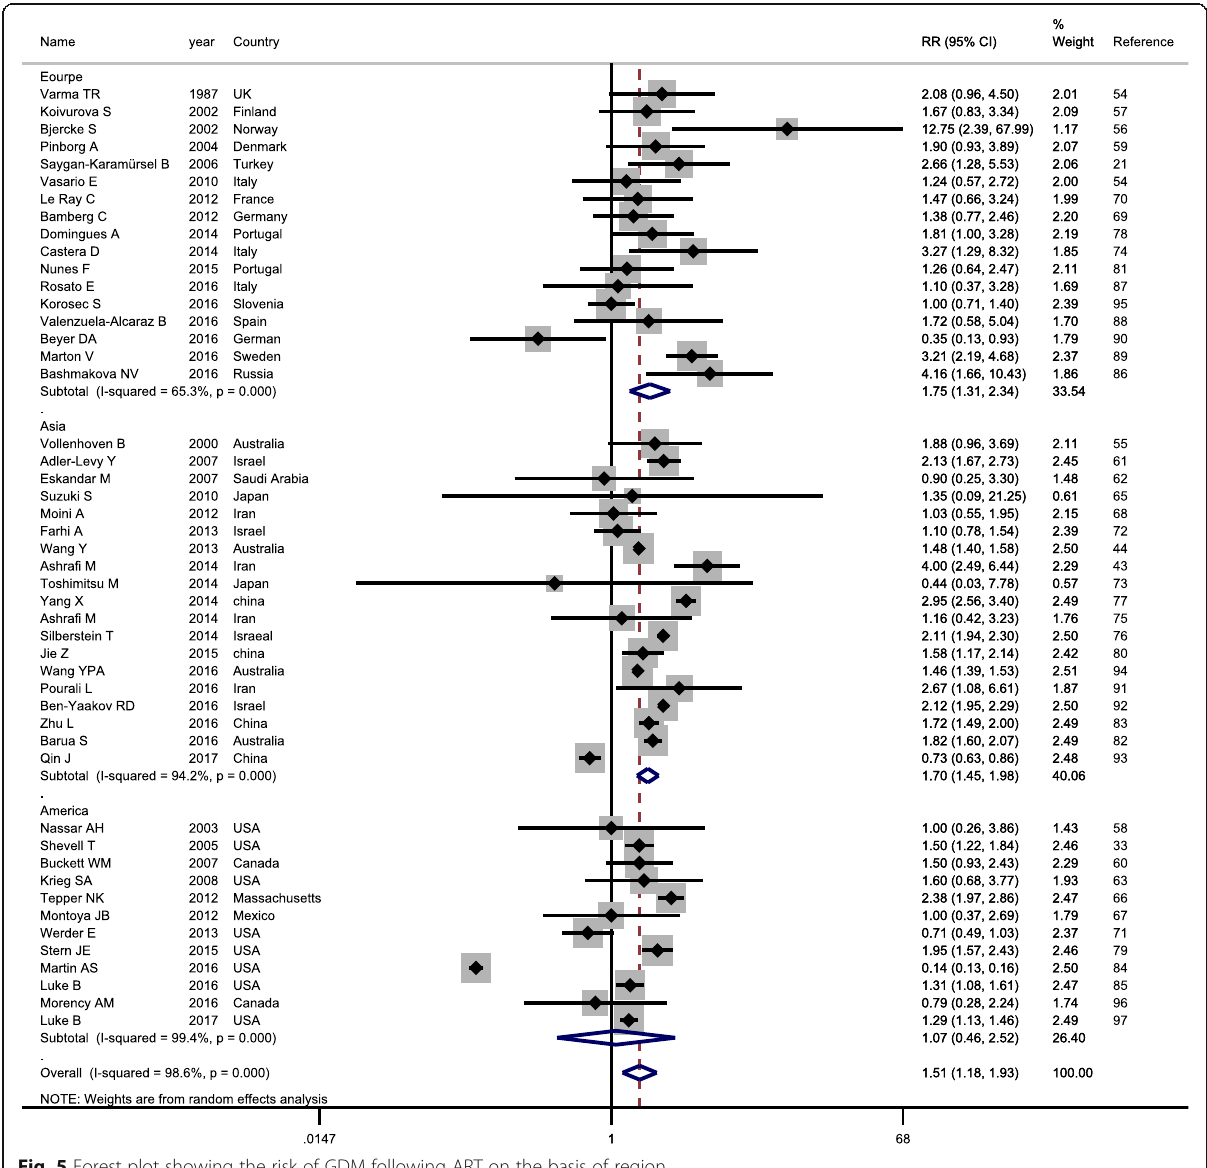
Fig. 5 Forest plot showing the risk of GDM following ART on the basis of